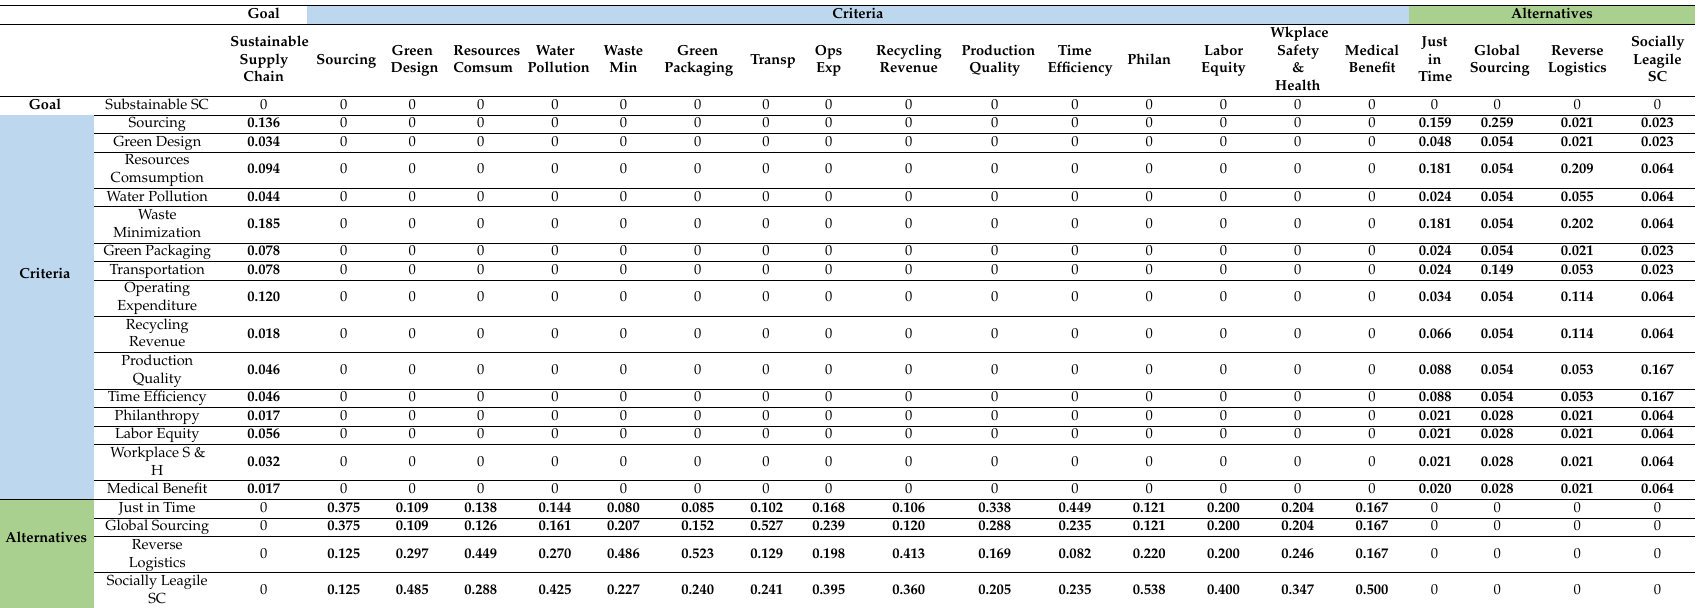
Table 15. Super matrix for the ANP